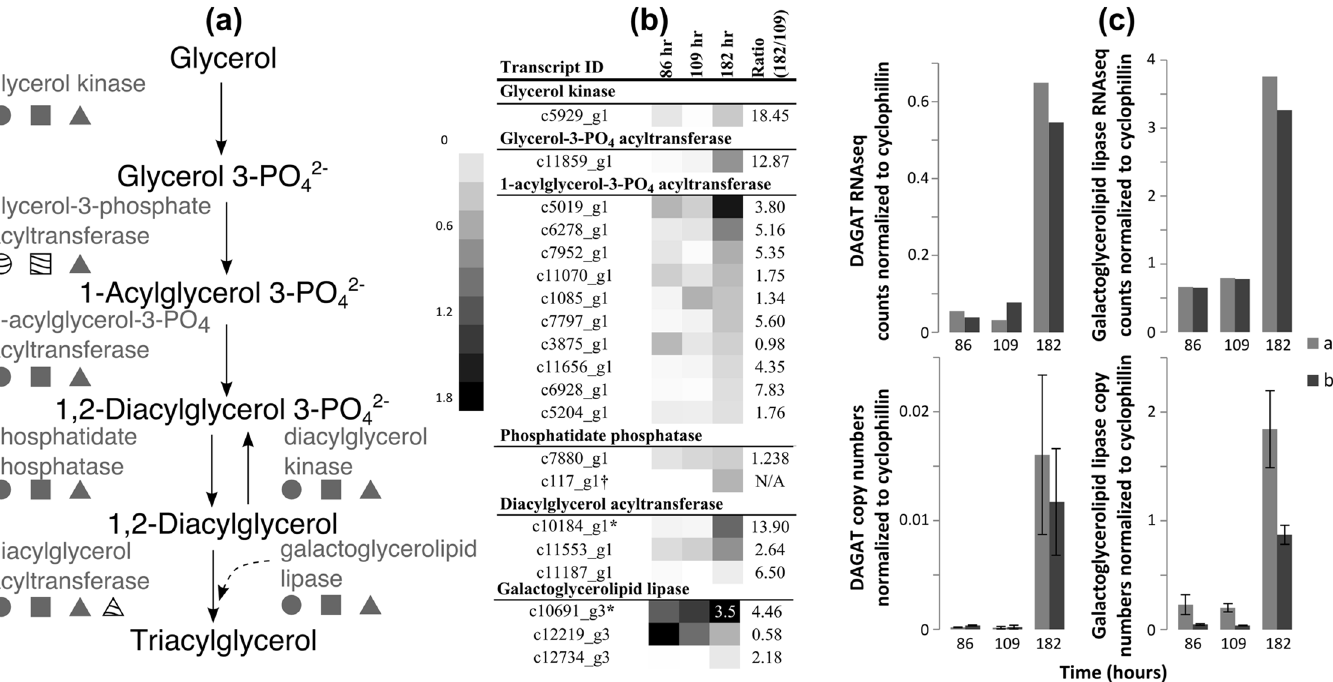
Fig 5. Detection and monitoring of the TAG biosynthesis pathway in Chlorella strain C596. (a) The final steps of the TAG biosynthesis pathway. The symbols indicate whether one or more transcripts encode the enzyme at that step is present for Chlorella strain C596 (circle), C. variabilis NC64A (square), or C. reinhardtii (triangle). Grey shading indicates presence. Lined shading for the glycerol-3-phosphate acyltransferase indicates a bacterial-type homolog. Lined shading for the diacylglycerol acyltransferase indicates a secondary homolog in C. reinhardtii . (b) Heatmaps of the cyclophillin-normalized values for the putative transcripts for the TAG accumulation pathway and galactoglycerolipid lipase in samples taken during exponential growth (89 and 109 h) and during lipid accumulation (182 h). The intensity of the shading represents cyclophillin normalized values ranging from 0 to 1.8; note, one transcript, c10691_g3, falls outside of this range and the appropriate box is labeled. The * symbol represents those transcripts for which RT-qPCR primers were designed. The † symbol represents the transcript whose ratio could not be calculated because the transcript was not detected in the 109 h sample. (c) Comparison of the RNA-seq (top row) and RT-qPCR results also normalized to cyclophillin (bottom row) for the predicted DAGAT (left column) and galactoglycerolipid lipase (right column) for two biological duplicates (a and b). The error bars indicate the 95% confidence interval of the technical replicates run for the